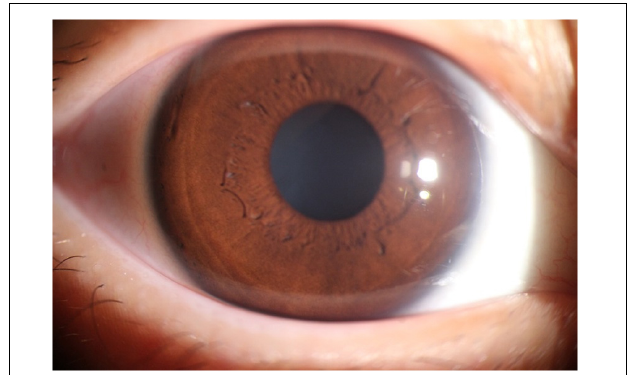
FIGURE 1 | An example of the Normal group.